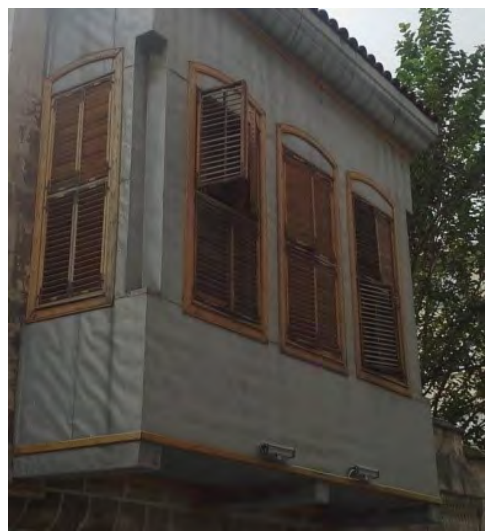
Figure 14. Wooden shutters (Tas¸tan,2014)